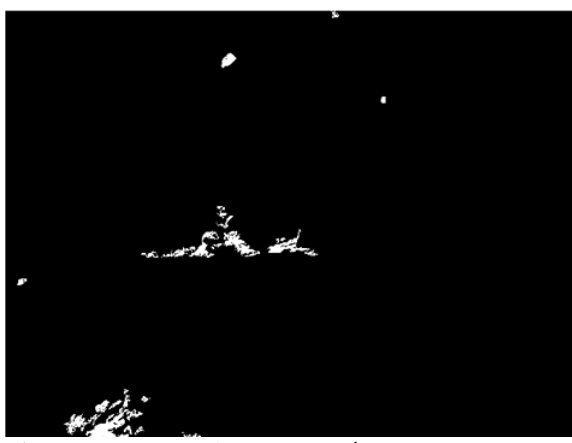
Figure 9. Post classification result (connected region area threshold: 100 pixels).